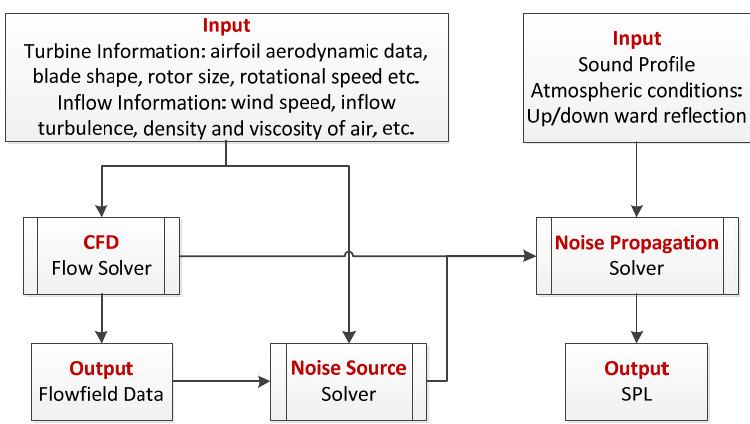
Figure 1. Schematic diagram of relations between the developed solvers.